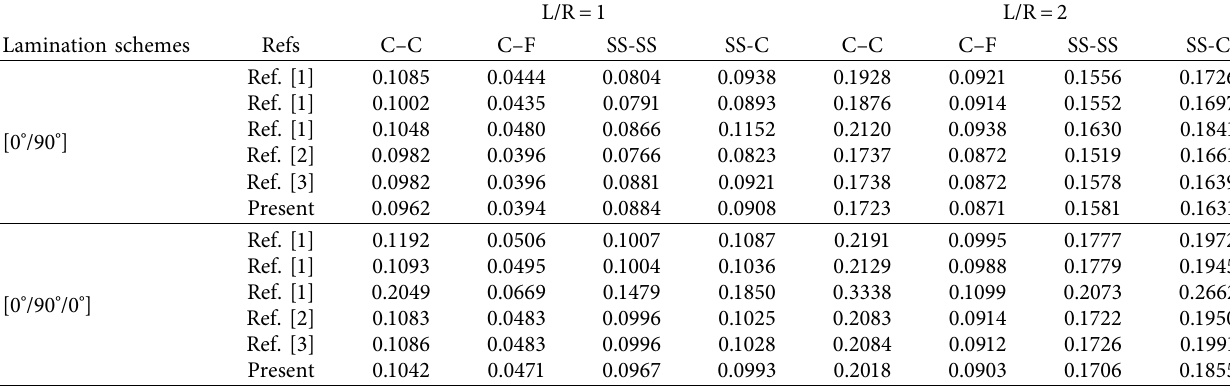
Table 2: Comparison of the fundamental frequency parameters Ω � ω L2/100h( ρ / E 2)1/2 of two certain cross-ply laminated cylindrical shells with different length–radius ratios and boundary conditions ( R � 1m, h/R � 0.2, E22 � 1GPa, E11 � 40GPa, μ 12 � 0.25, G12 � 6 GPa, G13 � G23 � 5GPa, ρ � 1600kg/m3).